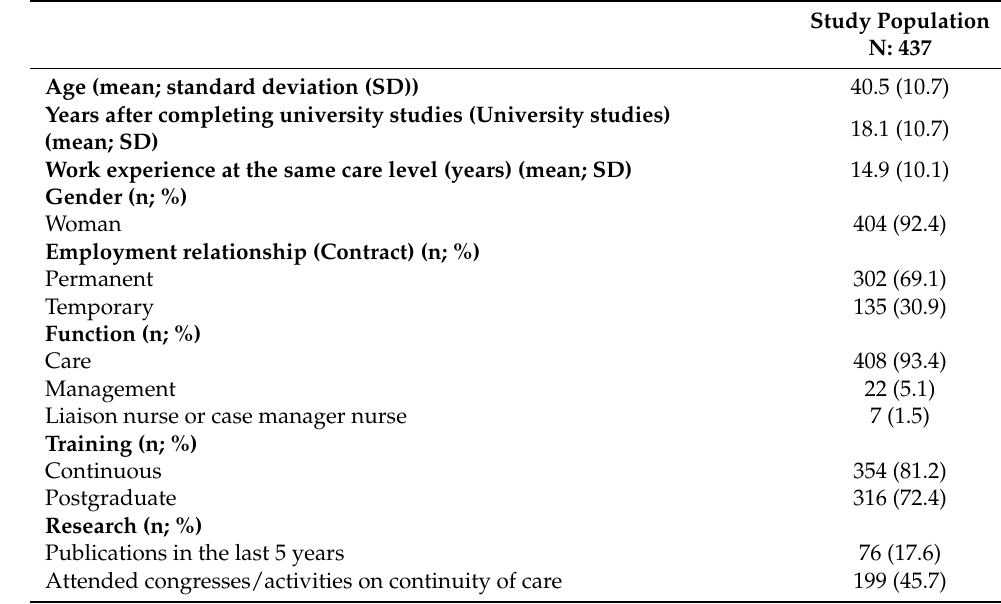
Table 1. Sociodemographic and employment characteristics of the